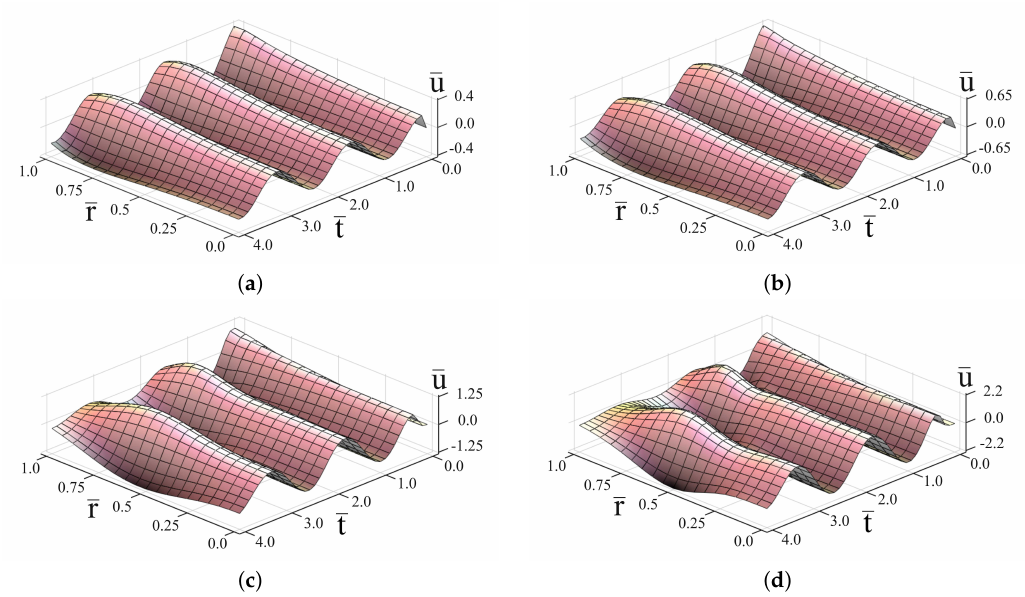
Figure 2. Evolution of the solution for the problems (12)–(15) under harmonic impact. The results of computer simulation of the formula (27) for the parameters ¯ b = 4, ¯ ω = 4 and different values of α : α = 0.5—( a ); α = 0.75—( b ); α = 1.25—( c ); α = 1.5—( d